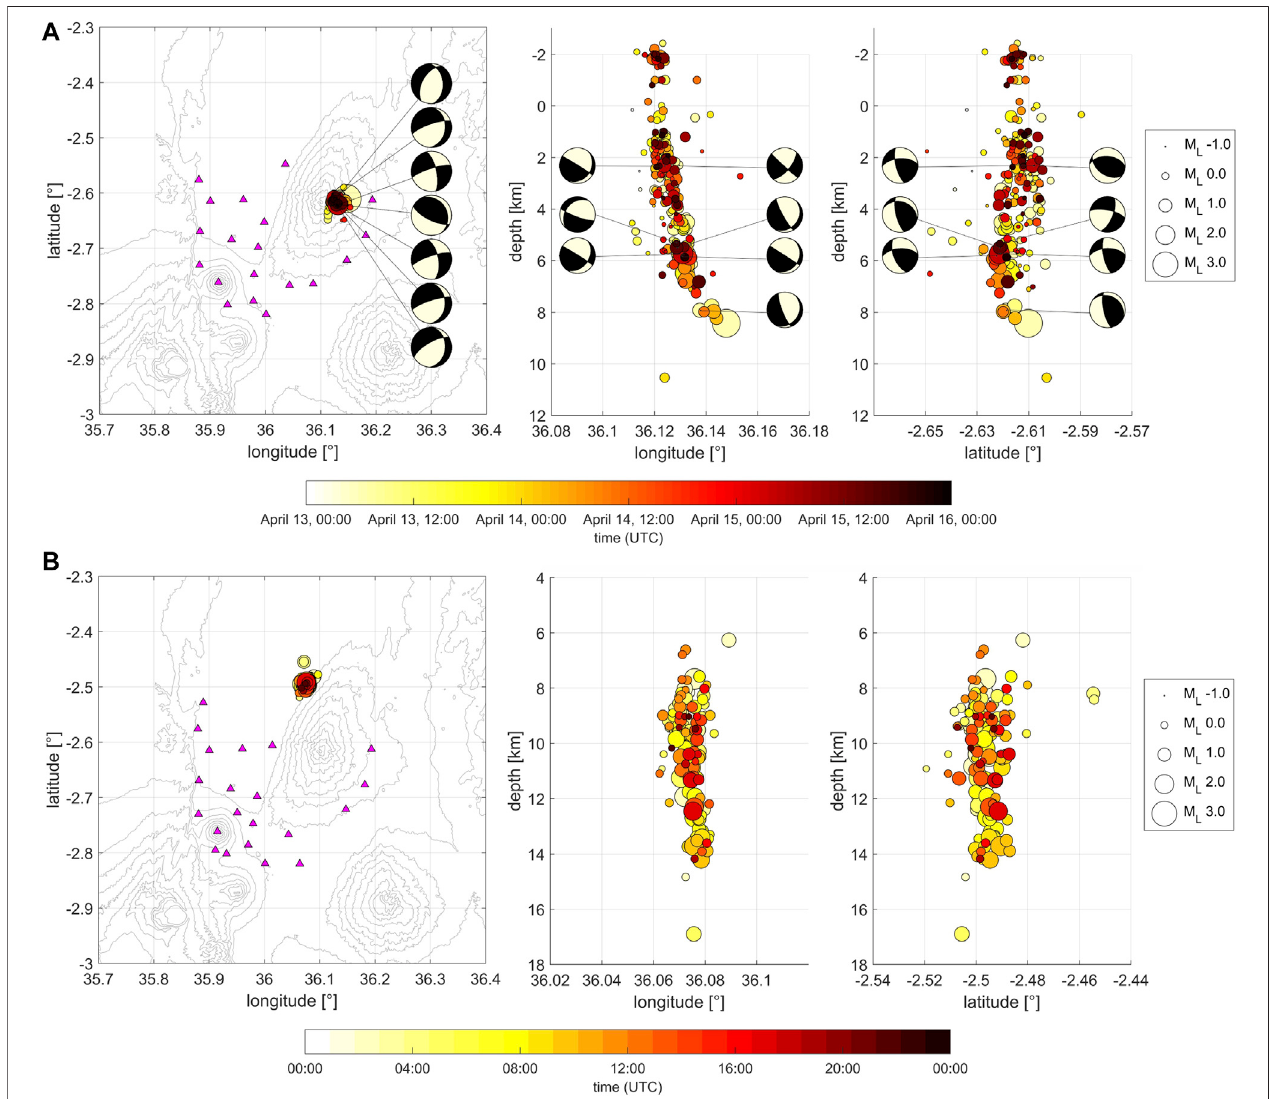
FIGURE 9 | (A) Left: Map view of fi rst seismic swarm April 13th – 15th 2019. Purple triangles are seismic stations running at the time. Circles are earthquakes colored by time and their size corresponds to their magnitude. Center: Enlarged vertical cross-sections of earthquakes along x-axis of left . Right: Enlarged vertical cross-sectionoftheirappearanceinearthquakesalongy-axisof left) .Ineverysubpanel,focalmechanismsareshowninthemargins andconnectedtothehypocenters withblack lines. (B) Left: Map view of fi rstseismic swarm on October 10th, 2019. Purpletriangles are seismic stations running at thetime. Circles are earthquakes coloredbytimeandtheirsizecorrespondtotheirmagnitude. Center: Enlargedverticalcross-sectionsofearthquakesalongx-axisof left . Right: Enlargedverticalcross- section of their appearance in earthquakes along y-axis of left .